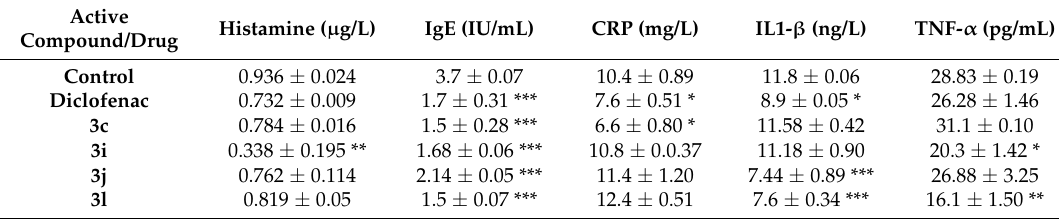
Table 4. Active compounds against inflammatory mediators in comparison with